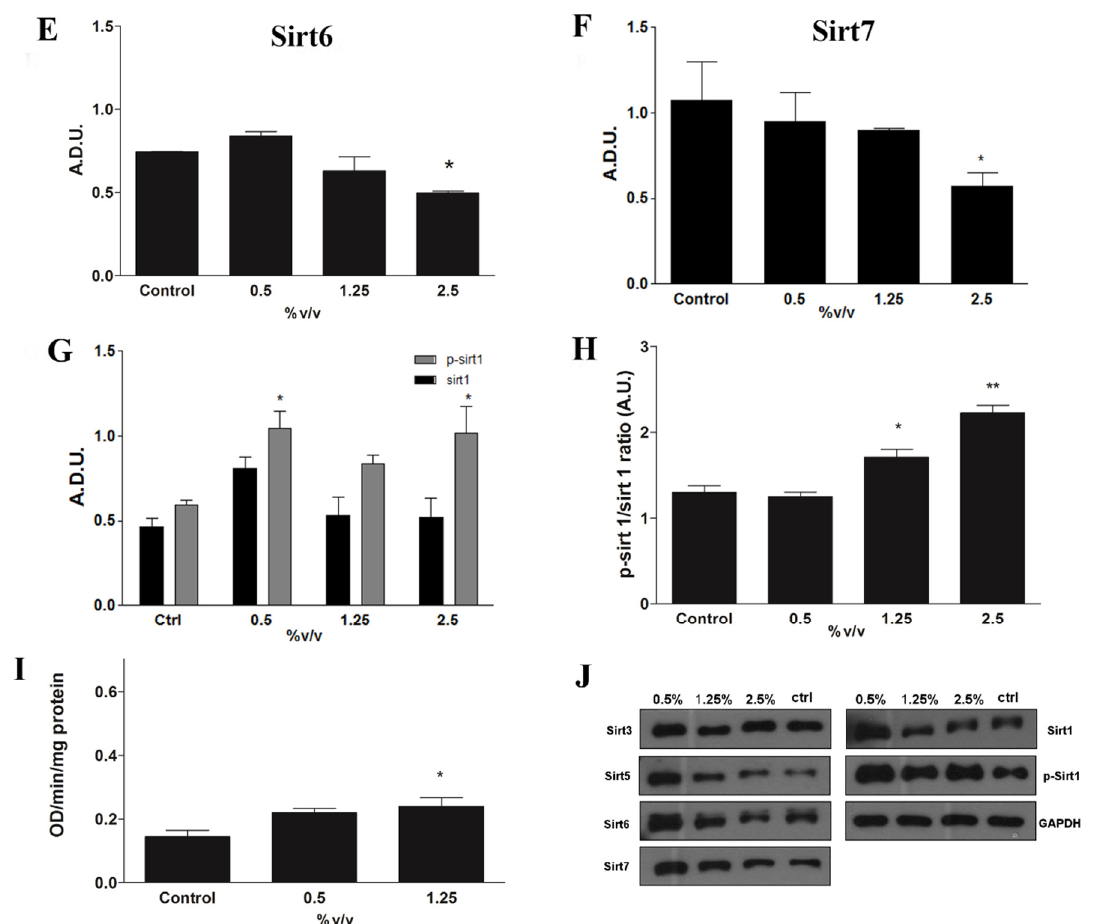
Figure 9. Epigenetic modulation in 1321N1 cells untreated and treated for 24 h with different concentrations of Rapha Myr ® extract depending on each cell-based assay protocol. ( A ) Global DNA methylation evaluated by Methy-sens comet assay. ( B ) Changes in mRNA level of DNA methyltransferase1 (DNMT1). Western blot of mitochondrial Sirt3 (C) and Sirt5 ( D ). Western blot of nuclear Sirt6 ( E ), Sirt7 ( F ), Sirt1 and pSirt1 ( G ), and pSirt1/Sirt1 ratio ( H ). Each bar graph shows the relative expression of the respective protein level. ( I ) Nuclear sirtuins activity expressed as OD/min/mg proteins. ( J ) Representative immunoblotting image of each protein examined. All values are mean ± SD of three experiments in triplicate. * p < 0.05 vs. control; ** p < 0.01 vs. control; *** p < 0.001 vs. control.